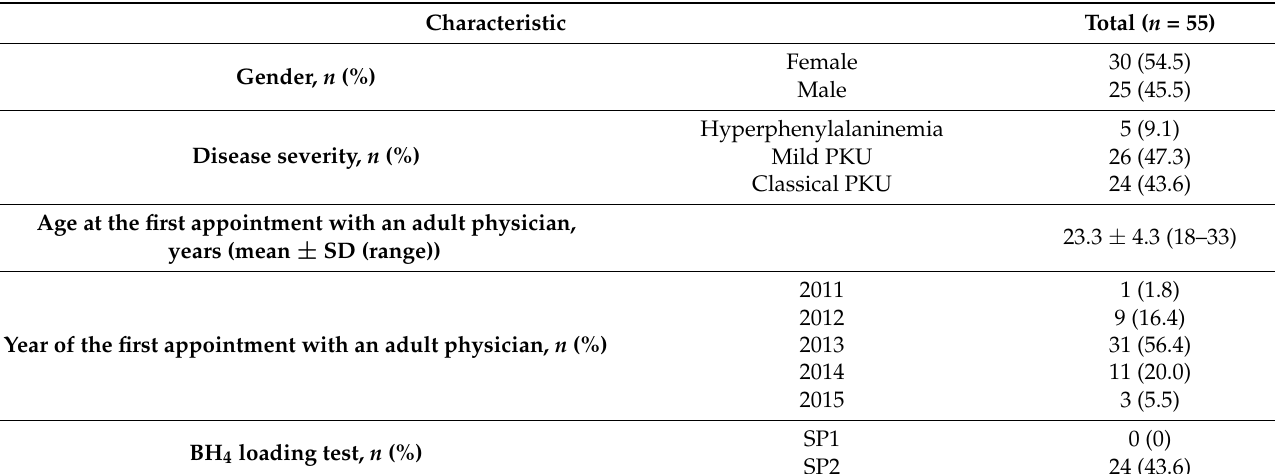
Table 1. Gender, disease severity, age and year of the first appointment with an adult physician, and enrolment to a BH 4 loading test.